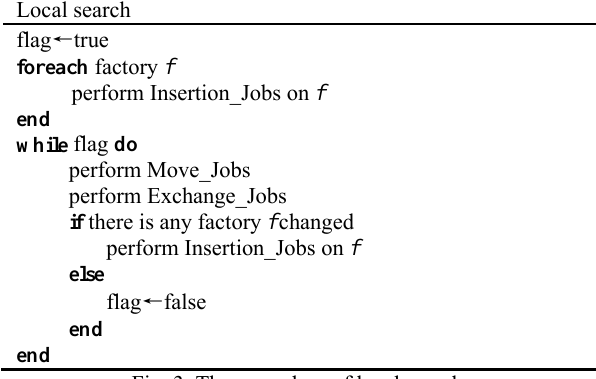
Fig. 3. The procedure of local search.